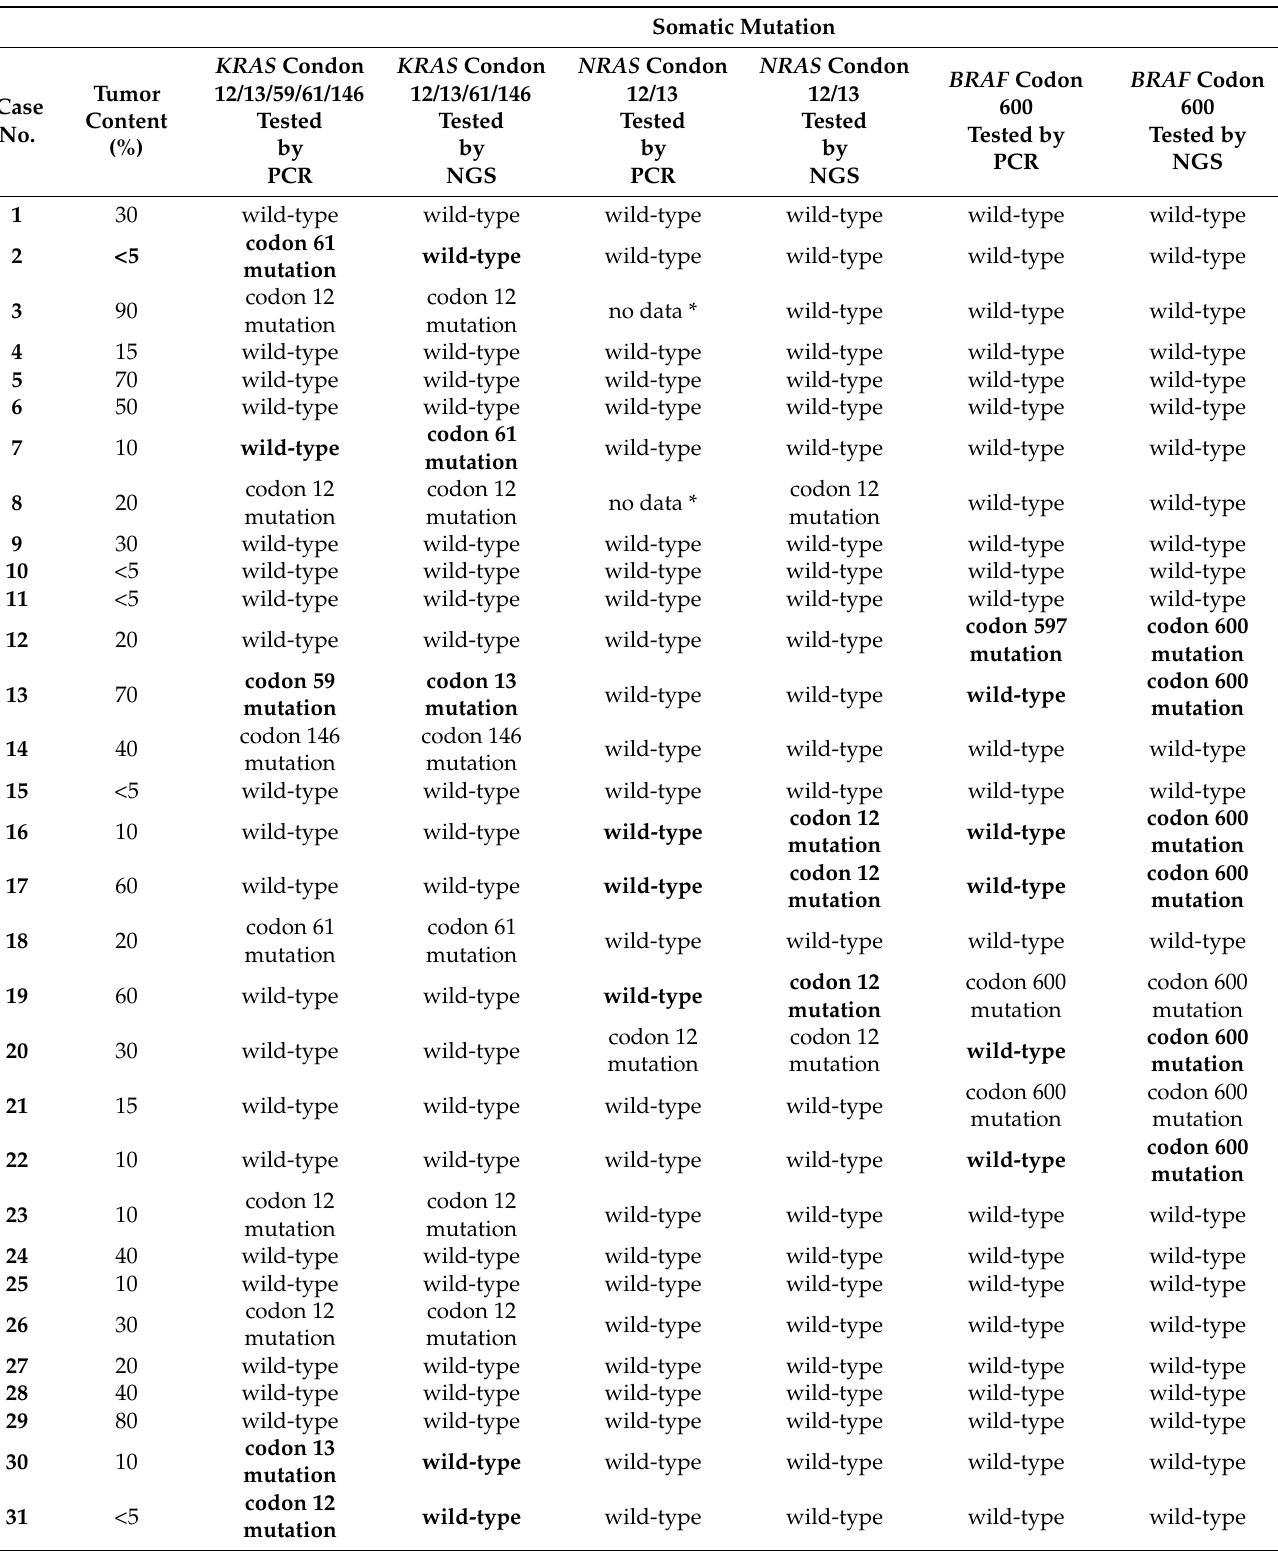
Table 2. Comparison of PCR versus NGS for testing of targeted genes in patients with mCRC ( n = 41). Somatic